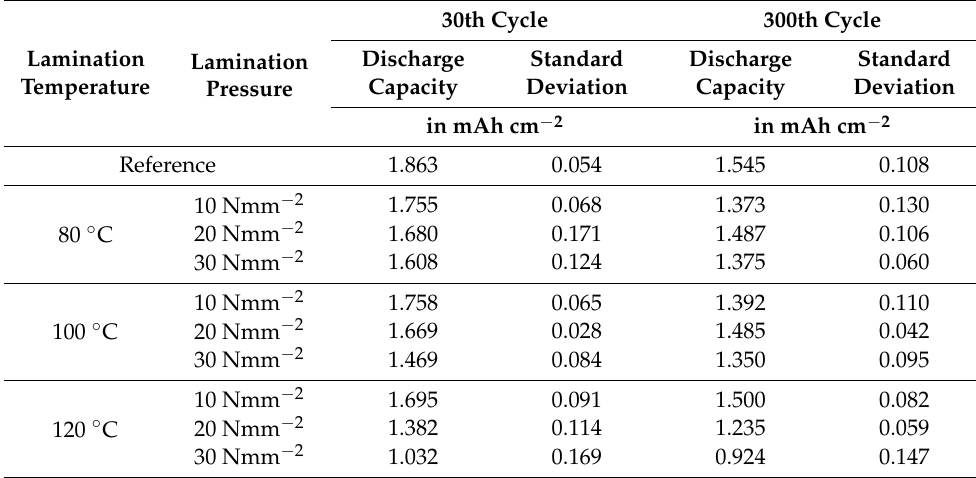
Table 1. Mean specific discharge capacity after 30 and 300